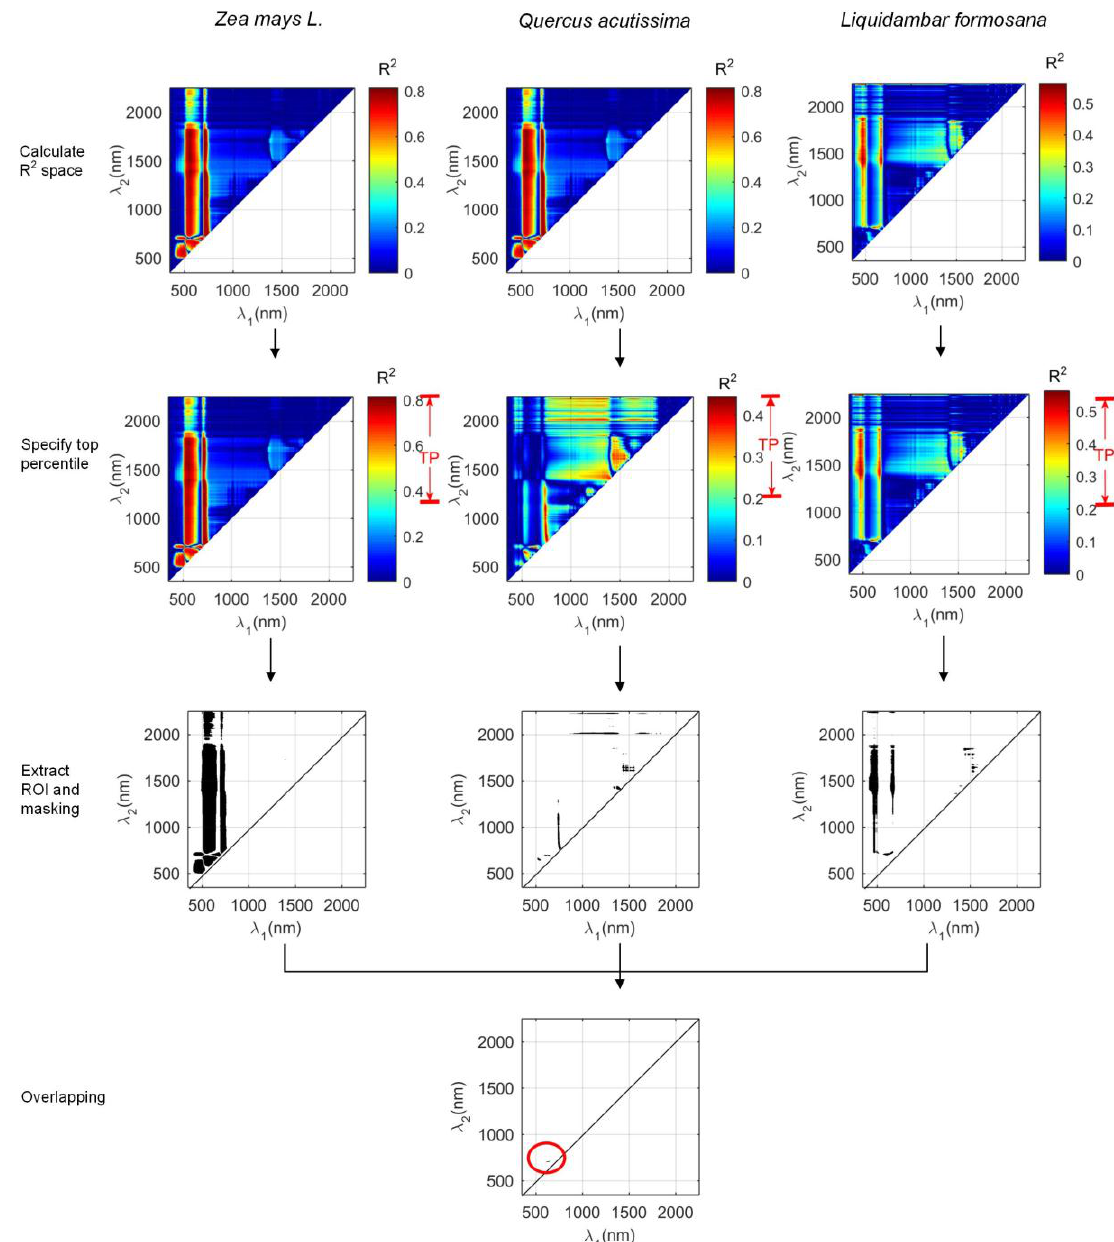
Figure 2. Main steps to finding the cross-species spectral index under a certain top percentile, taking Normalized Difference Spectral Index (NDSI) as an example.